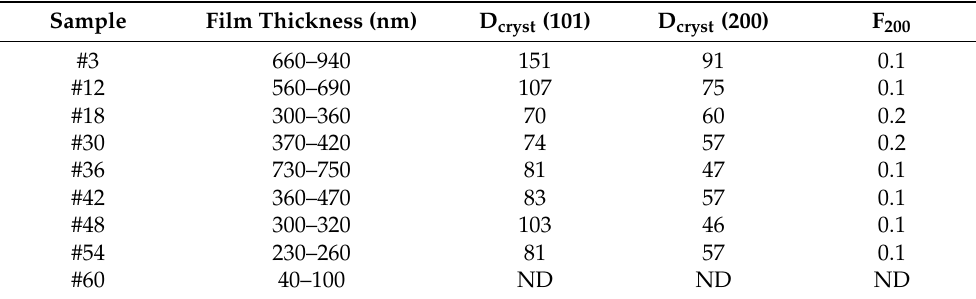
Table 1. Main experimental data obtained for the TiO 2 -SSM portions characterisation. Concerning the film thickness, the minimum and maximum values are given. Crystallite dimensions (nm) determined by Scherrer’s equation were calculated with respect to the main reflections of (101) and (200) planes (the uncertainty for each datum is ± 5 nm). F 200 is the Lotgering factor calculated for the (200) XRD